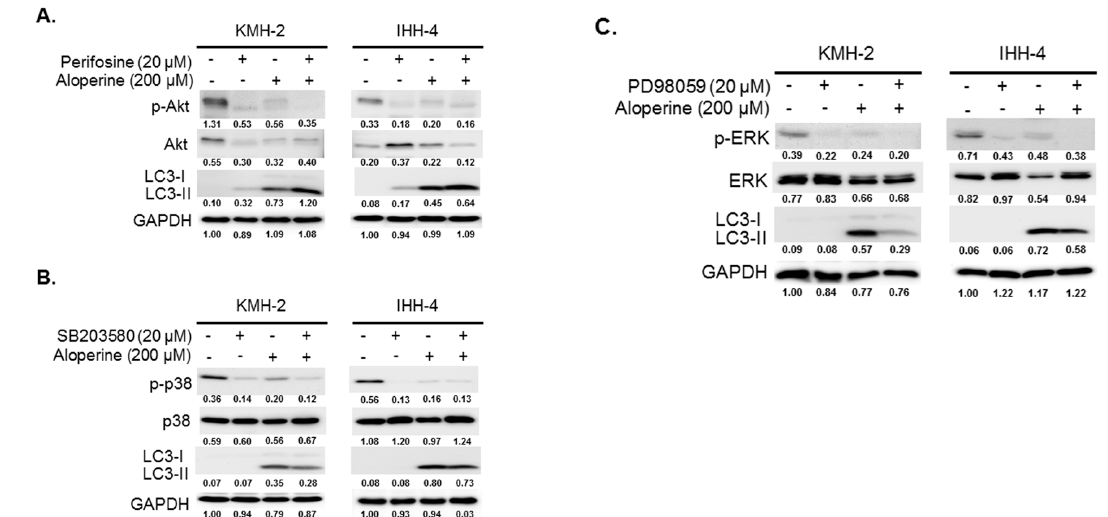
Figure 6. Evaluation of signaling pathways involved in aloperine-mediated autophagy induction in human thyroid cancer cells. To confirm the signaling pathways involved in aloperine-mediated autophagy induction, cells were treated with ( A ) perifosine (an Akt inhibitor), ( B ) SB203580 (a p38 inhibitor), or ( C ) PD98059 (an Erk inhibitor) with or without aloperine; LC3, phospho-Akt, phospho-p38, and phospho-Erk expression was examined using Western blotting after 24 h incubation. DMSO was used as a negative control. Numbers under the plots indicate the quantification of protein intensity after normalization with GAPDH. Three independent experiments were performed, and results of one of these are